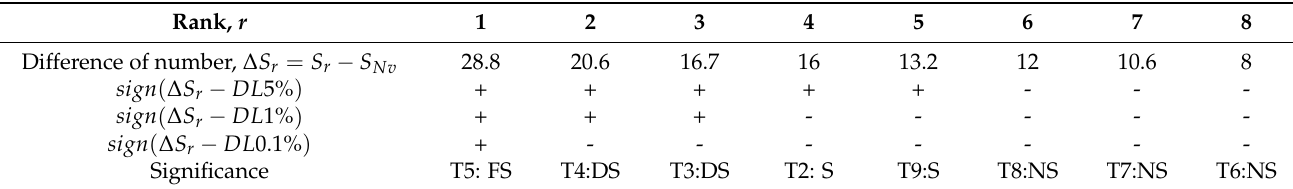
Figure 4. The average number of beans/plant for the soybean crops in the nine experimental variants. Error bar with standard error of deviation (%). Table 8. Centralization of the data necessary for the classification of variants by the DL test for the average number of